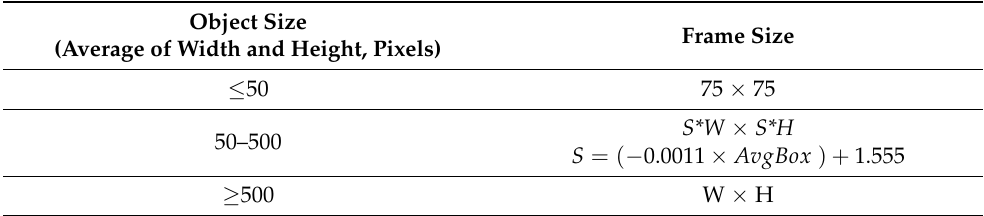
Table 1. Object frame size. W is object width, H is object height, S is scale factor, AvgBox is defined by averaging width and height in the spatial x and y domain.